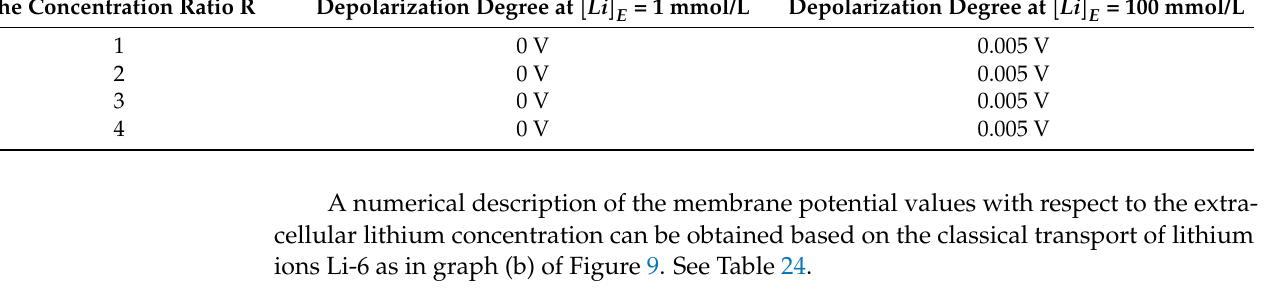
Based on Table 22, a numerical description of the depolarization degree can be ob- tained. See Table 23. Table 23. The table shows the depolarization degree based on the classical transport of Li-6 as in graph (a) of Figure 9. The Concentration Ratio R